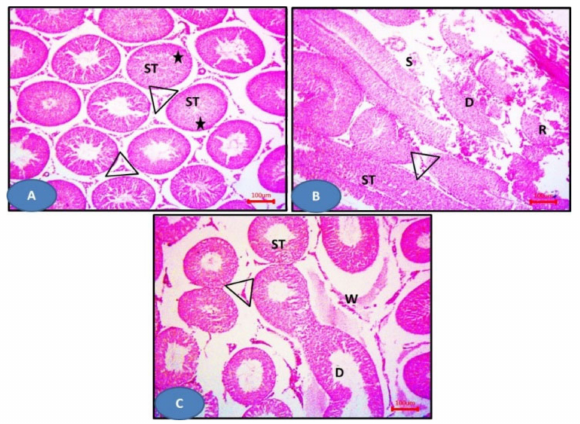
Figure 10. Photomicrographs of sections of the testis: ( A ) The sham group showing seminiferous tubules (ST) with germinal epithelium (stars) and Leydig cells (triangles). ( B ) Model group showing distorted seminiferous tubules lined (D) by disorganized epithelium. Notice the ruptured tubules (R) and the distorted Leydig cells (triangles). Sloughed cells (S) can be observed. ( C ) The NAC group showing more or less normal seminiferous tubules (ST) and Leydig cells (triangles), except some areas showing distorted tubules (ST). Notice the widening of inter-tubular spaces (W). H&E × 100.